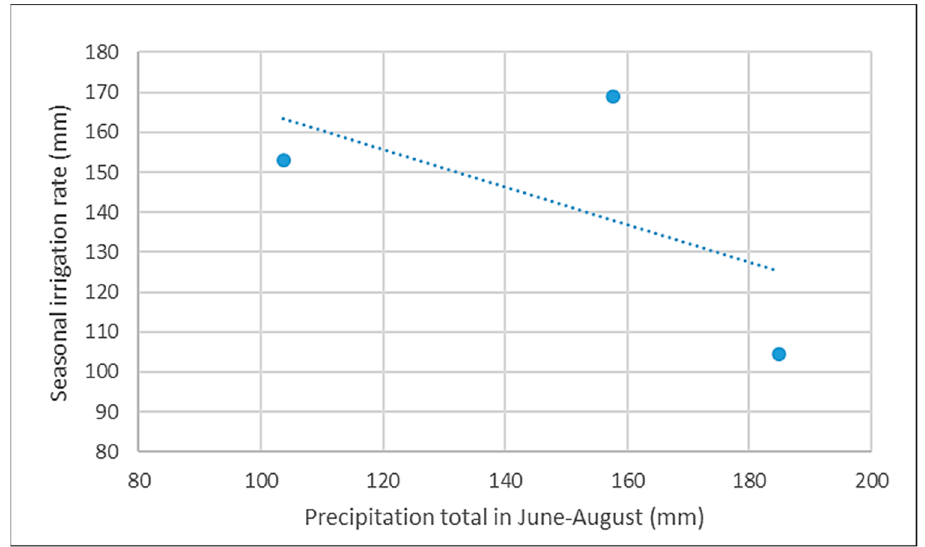
Figure 1. Relationship between precipitation (mm) and seasonal irrigation water rates (mm) of Melba and Seledyn melon